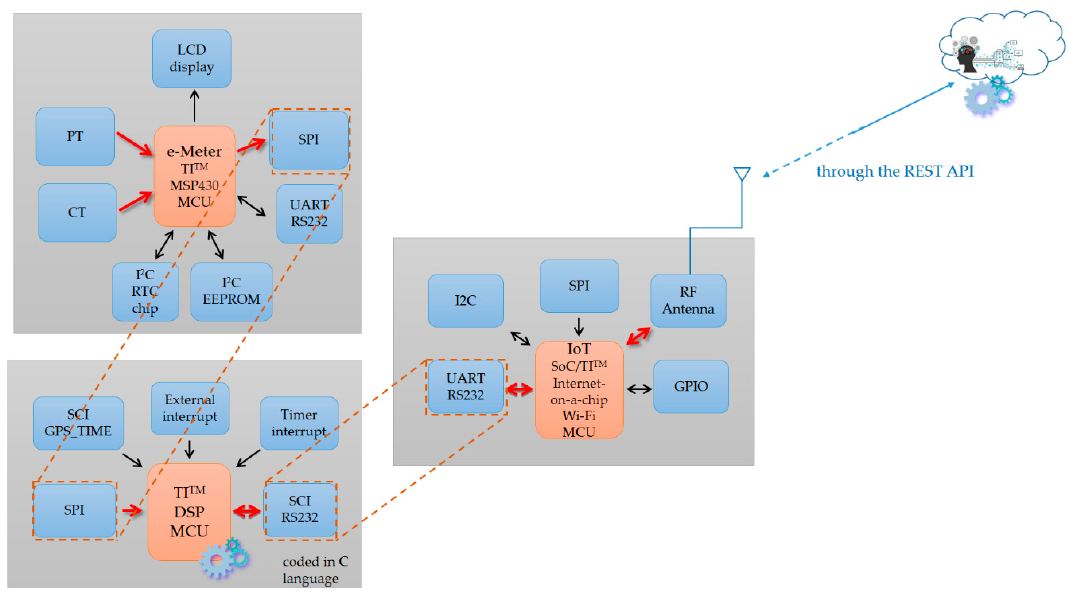
Figure 15. DSP MCU-versioned powerful smart autonomous power meter prototype.